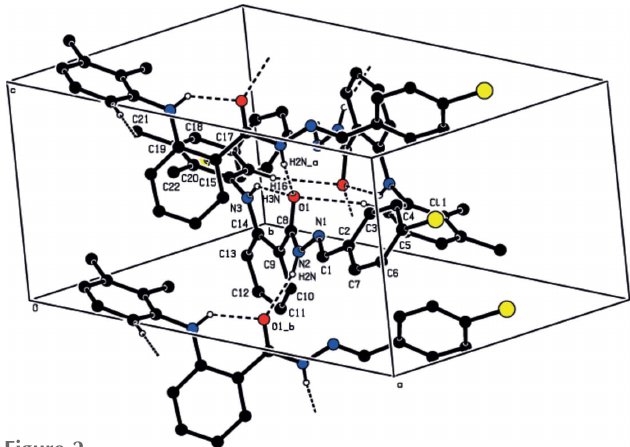
Figure 2 A part of packing diagram for the title compound, with hydrogen bonds drawn as dashed lines.